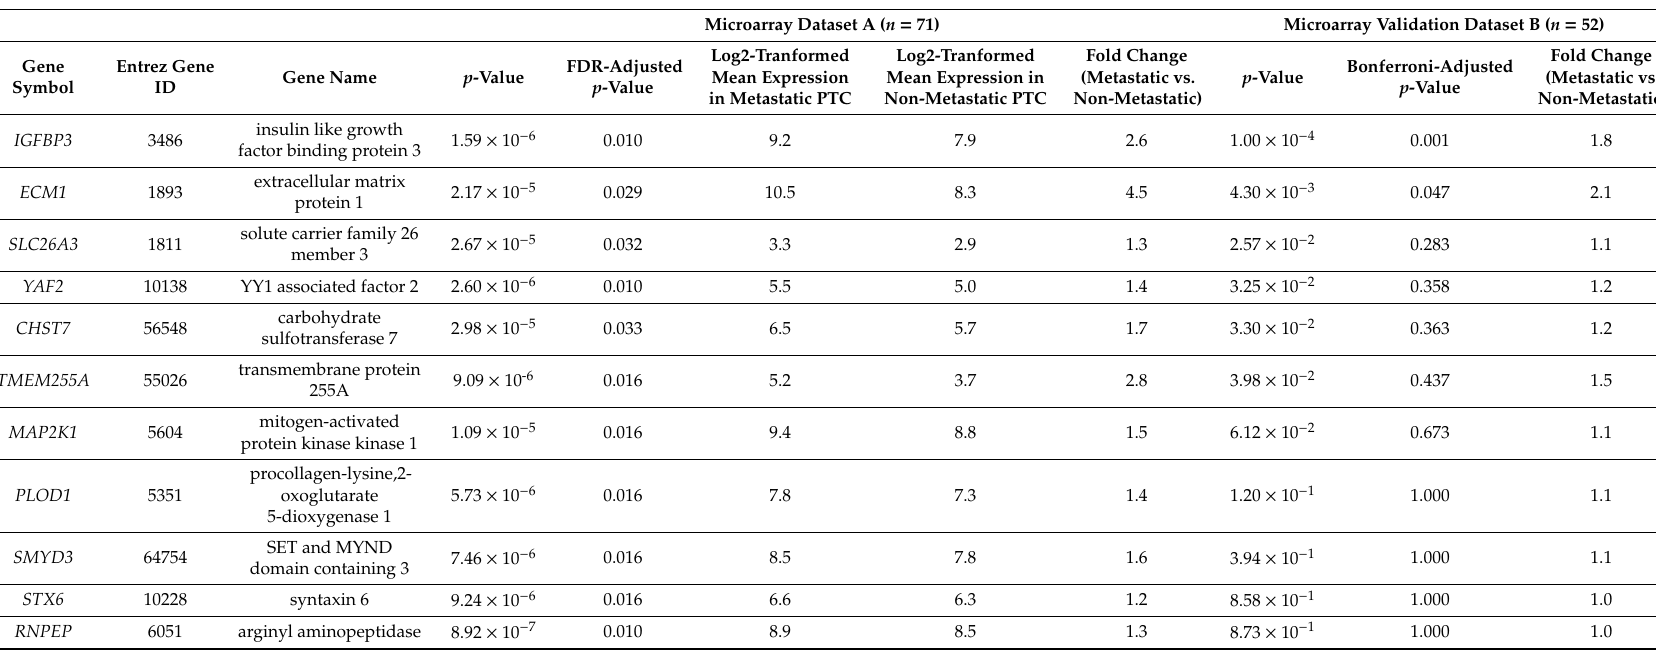
Table 1. Genes di ff erentially expressed between papillary thyroid cancer (PTC) with and without distant metastases. Genes were selected on microarray dataset A (71 PTC samples) and validated on microarray validation dataset B (52 PTC